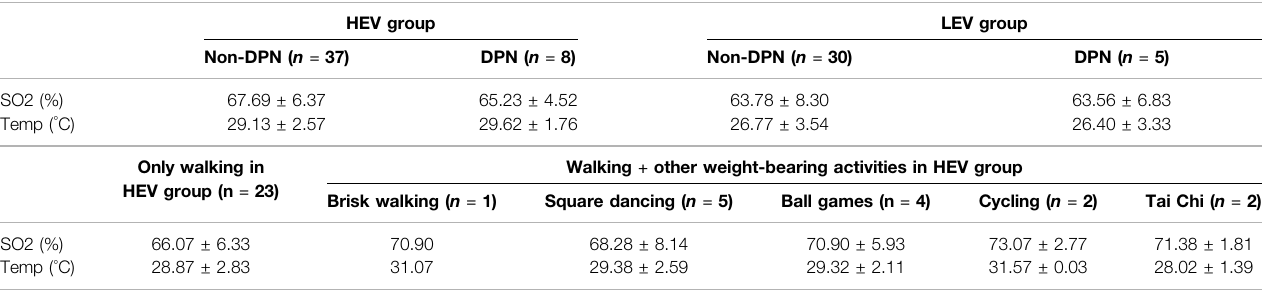
TABLE2| PlantarSO 2 andTempforNon-DPNandDPNparticipantsintheHEVandLEVgroups,andforNon-DPNparticipantsperformingdifferentphysicalactivitiesinthe HEV group (Participants in LEV group did not engage in any form of exercise other than walking; Mean ± SD).